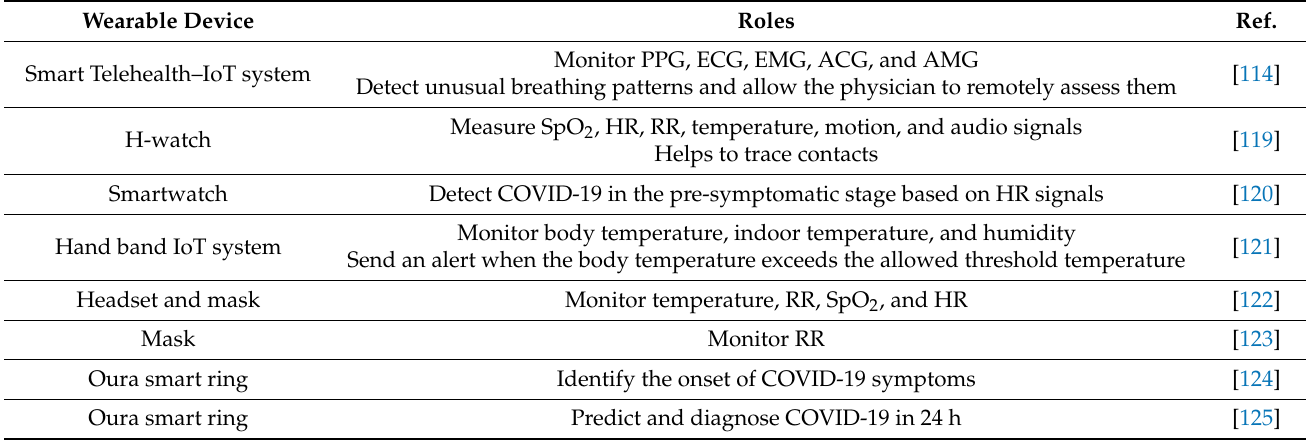
Table 2. Examples of recent studies on the remote management of